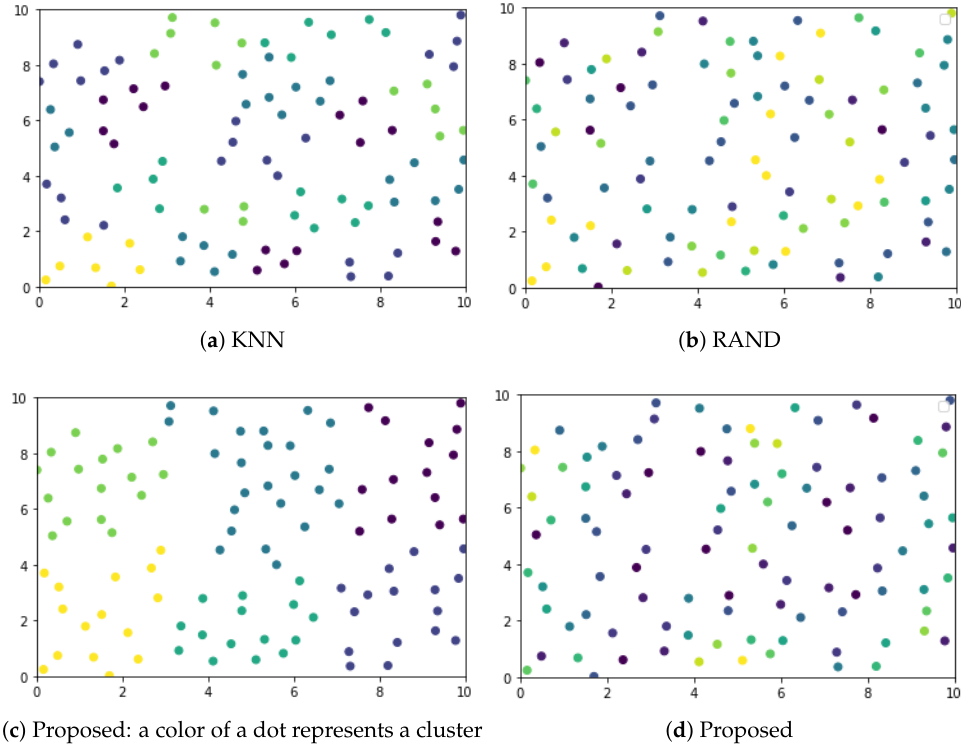
Figure 1. Comparison of the channel allocation behavior. Each dot represents a location of a WBAN. Except ( c ), where a color of a dot represents a channel allocated to a WBAN. The color of a dot in ( c ) represents a cluster. Thus, in ( c ), the WBANs having the same color belong to the same cluster.